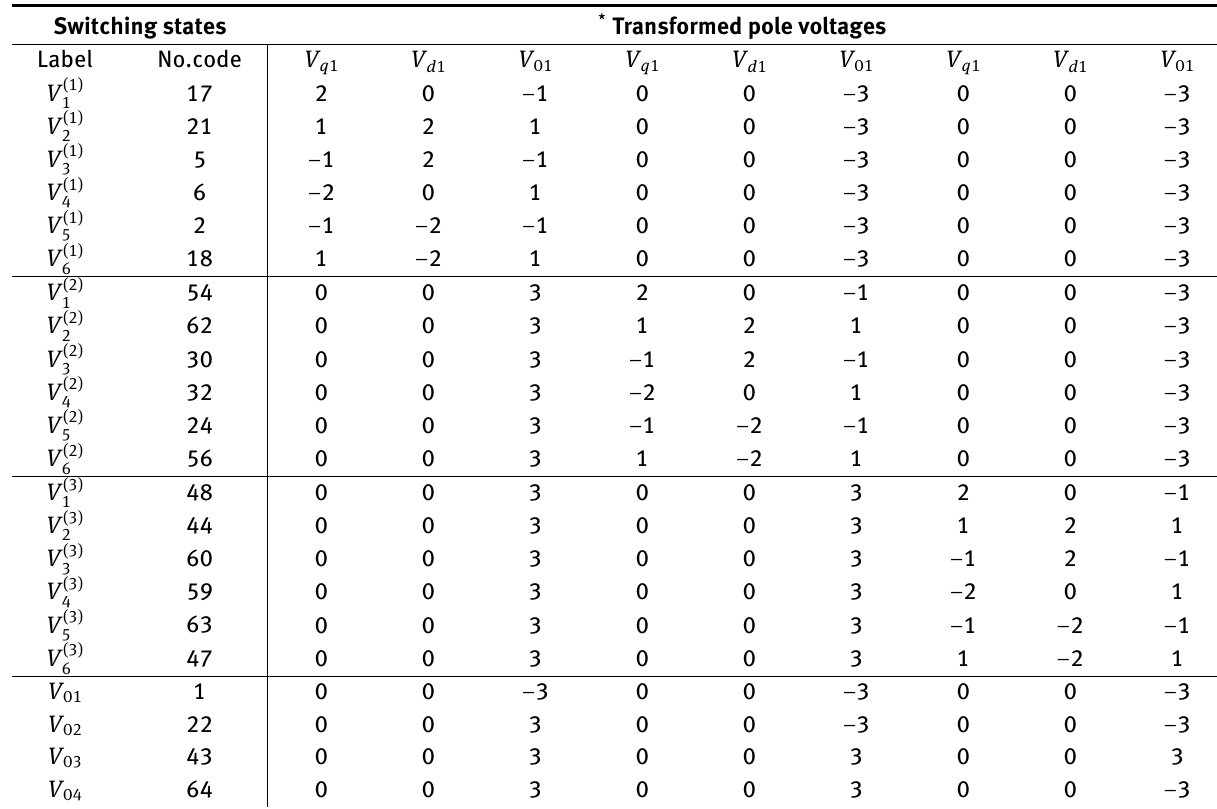
Table 1: Switching states for independent control of Inv 1, Inv 2, and Inv 3 . Switching